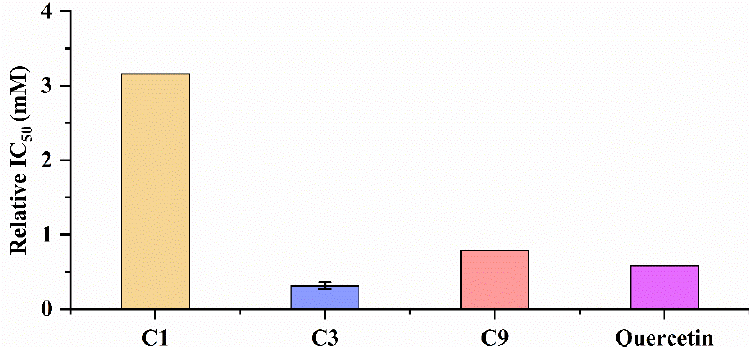
Figure 7. The relative IC 50 of potential ligands with SOD. C1: gallic acid; C3: protocatechuic acid; C9: ( − )-epicatechin.